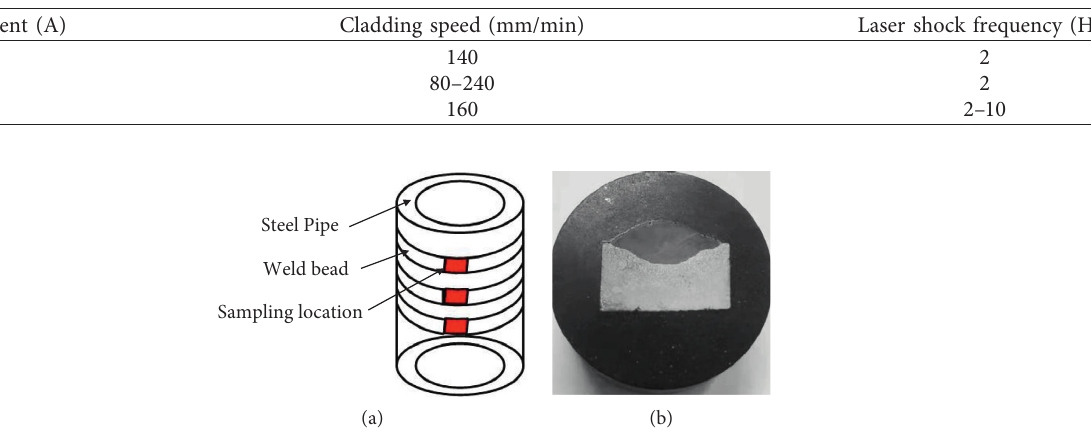
Figure 1: Arc welding-laser shock forging (AW-LSF) process setup. (a) Schematic view and (b) actual Table 2: AW-LSF process parameters and levels.